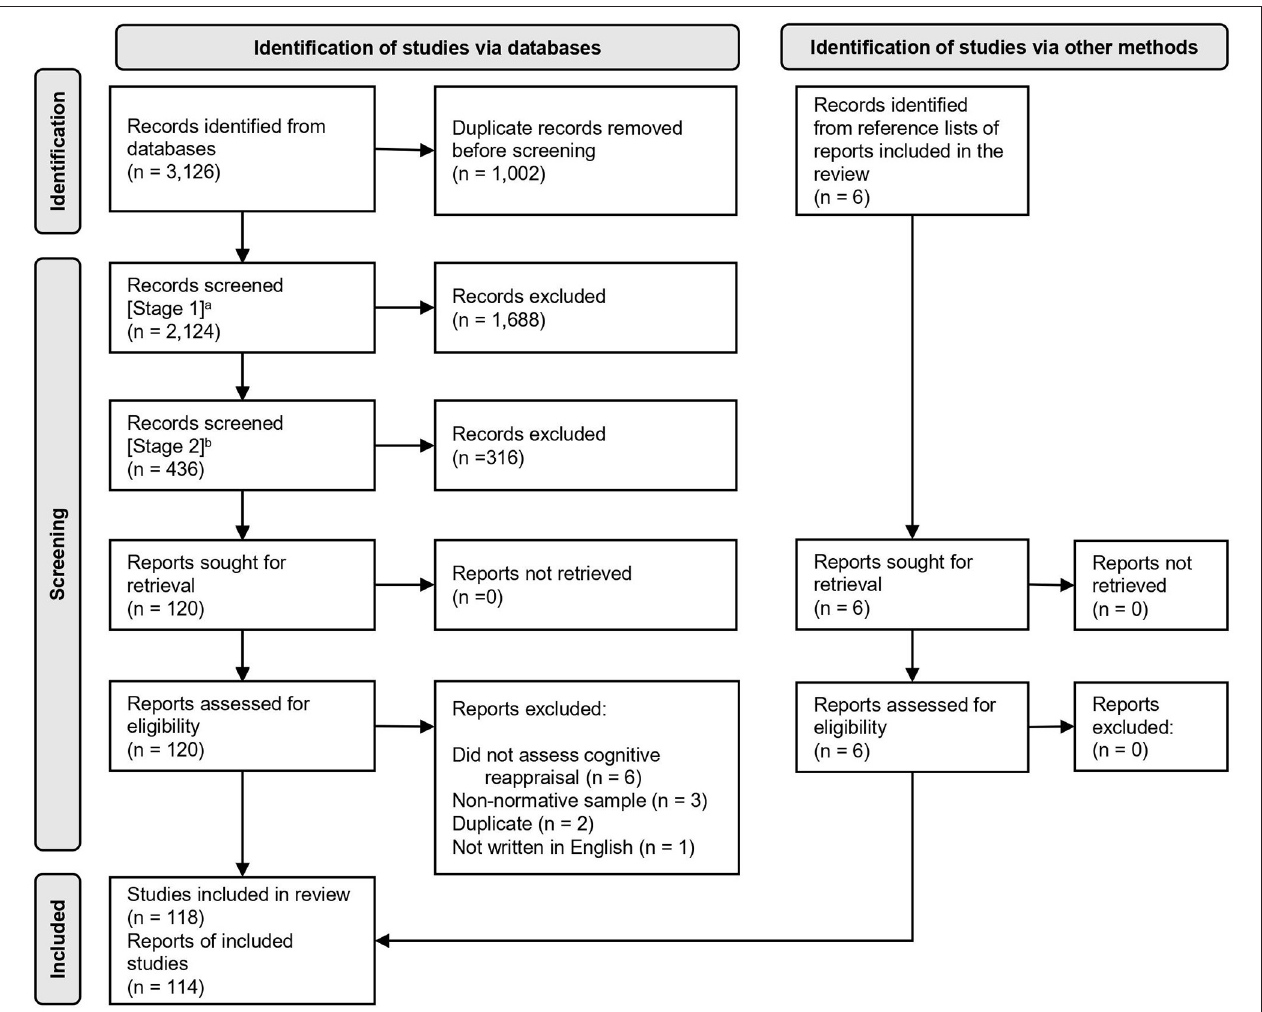
FIGURE 1 | Study identification and screening flow diagram. a In the first screening stage, records were retained if they were an empirical study (not a review) of the knowledge, choice, or use of specific emotion regulation strategies in children and/or adolescents between the ages of 3 and 18 years; they used a normative developmental sample; they were published in a peer-reviewed journal; and they were written in English. b In the second screening stage, articles were retained if the title or abstract contained the words “reappraisal,” “cognitive restructuring,” “reframing,” “re-evaluating,” or “cognitive emotion